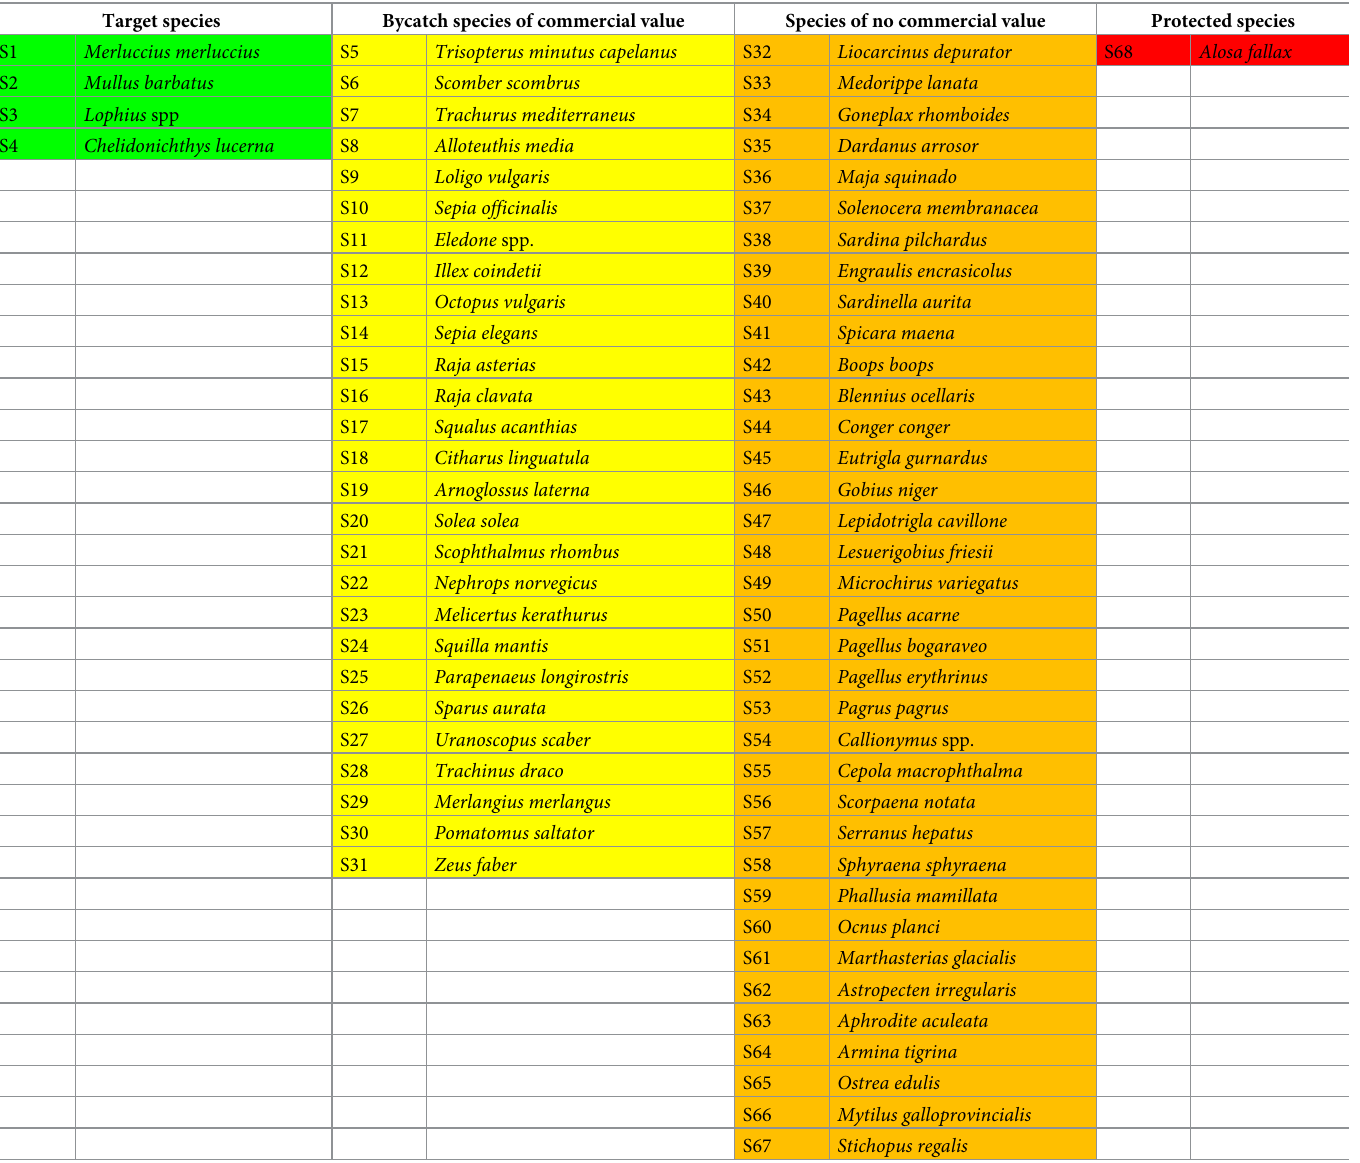
Table 2. Assigned ranking (S) of the animal species, divided by category, caught during the sea